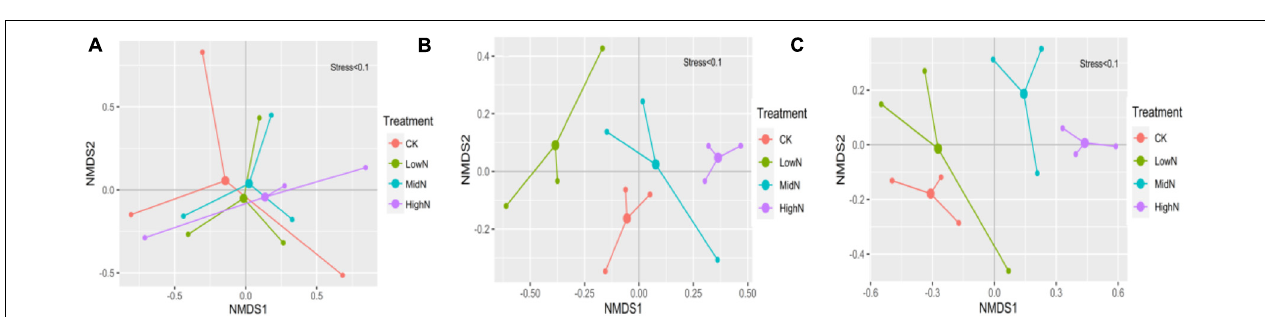
FIGURE 3 | Effect of nitrogen addition rate on species composition based on abundance from 2015 to 2017. Species denoted in color are graminoids (mostly grasses).